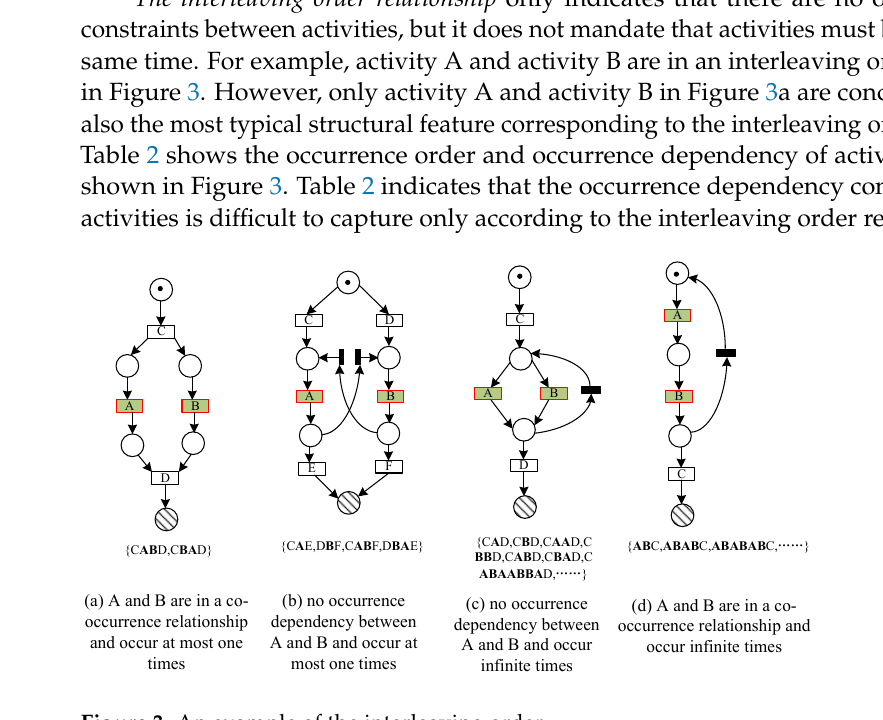
Figure 3. An example of the interleaving